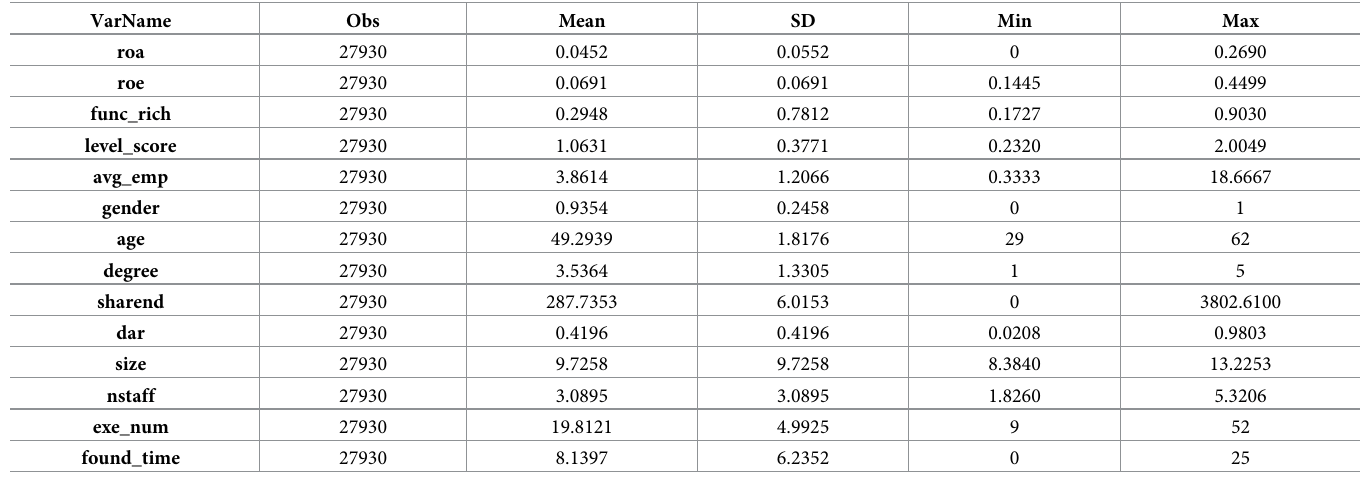
Depth: A CEO’s functional experience depth was measured by the function hierarchy Table 2. Descriptive